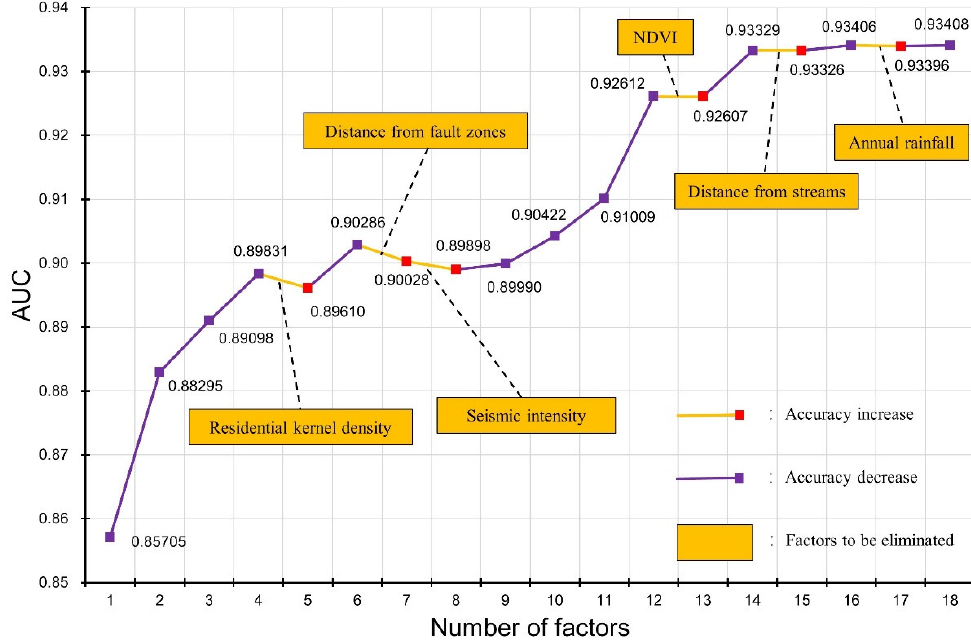
Figure 6. The results of recursive feature elimination based on GeoDetector.